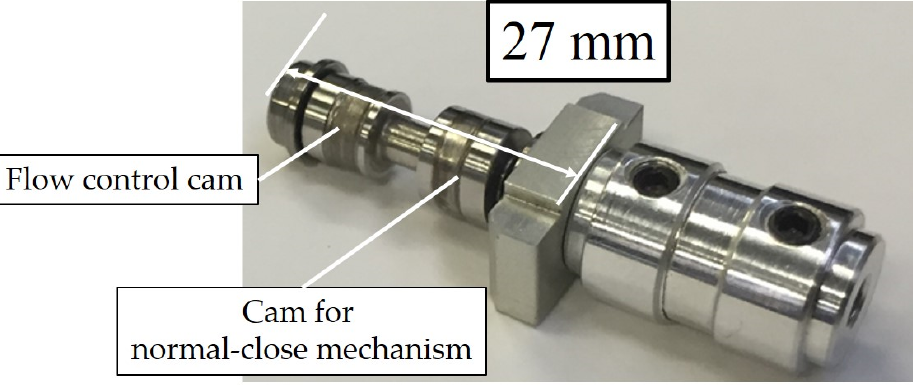
Figure 18. Inside the pinch mechanism without the cam shaft (after endurance test).